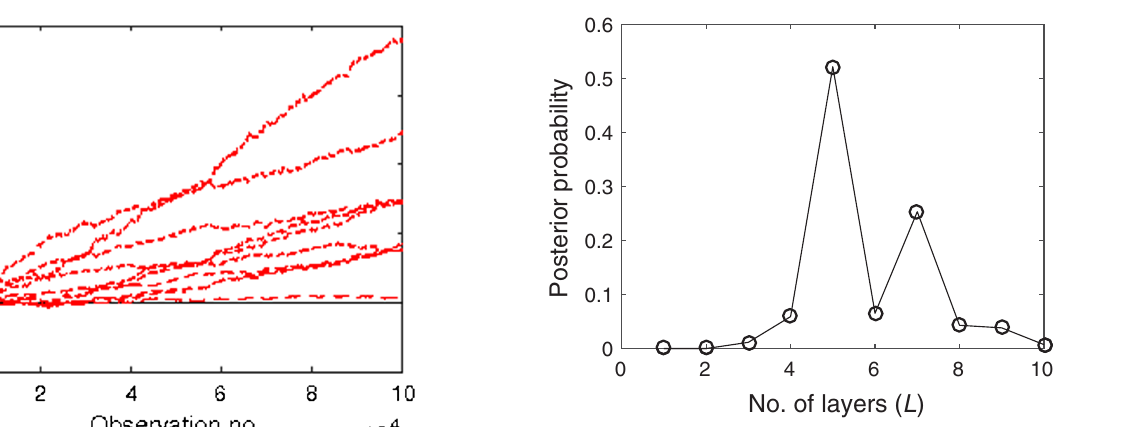
FIG. 21. Log-likelihood difference between a model with the true values and ten models with slightly perturbed values in the parameters, as a function of the size of the observation sequence.